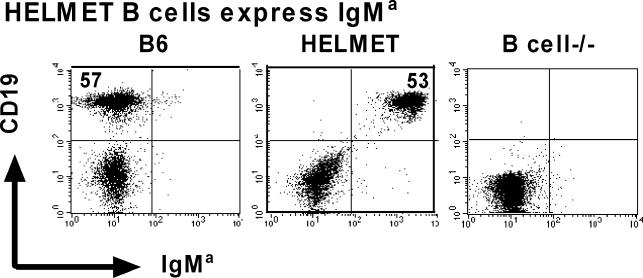
HELMET Mice Contain Transgenic B CellsSplenocytes from naïve B6, HELMET, and B cell−/− mice were stained with antibodies against CD19 and IgMa. Numbers represent percentages of cells in the indicated quadrants.